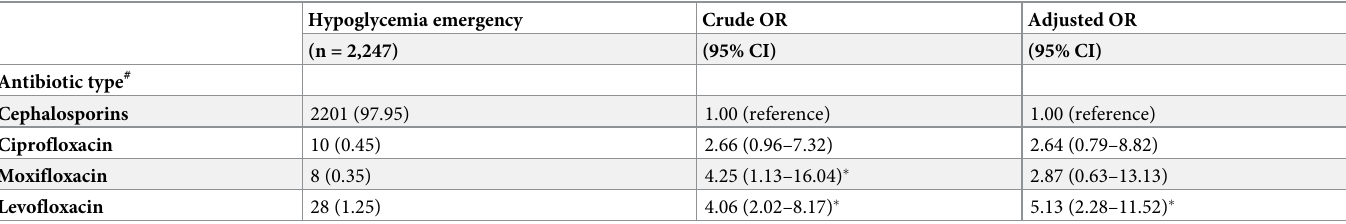
Table 3. Comparison of different types of quinolones and cephalosporins usage as exposure towards the risk of developing hypoglycemia emergency (event).